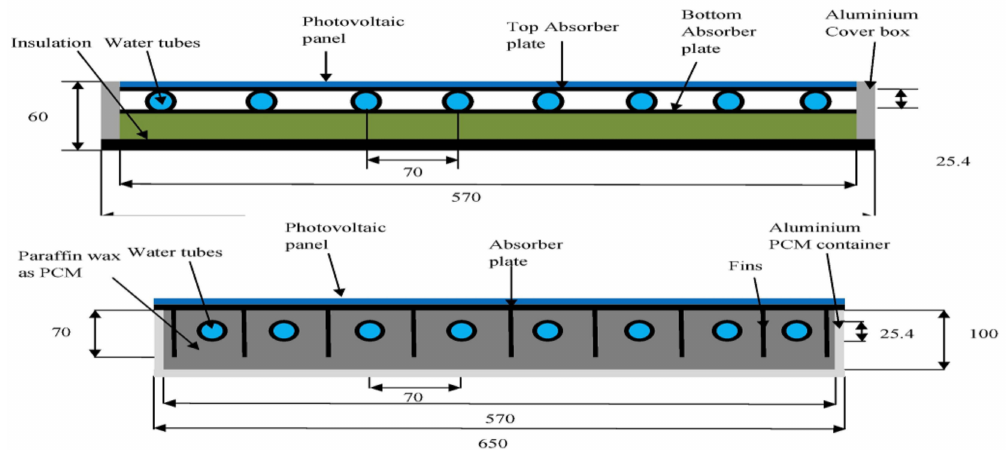
Figure 22. PVT-water and PVT-PCM-water configurations (reprinted from [116], with permission from